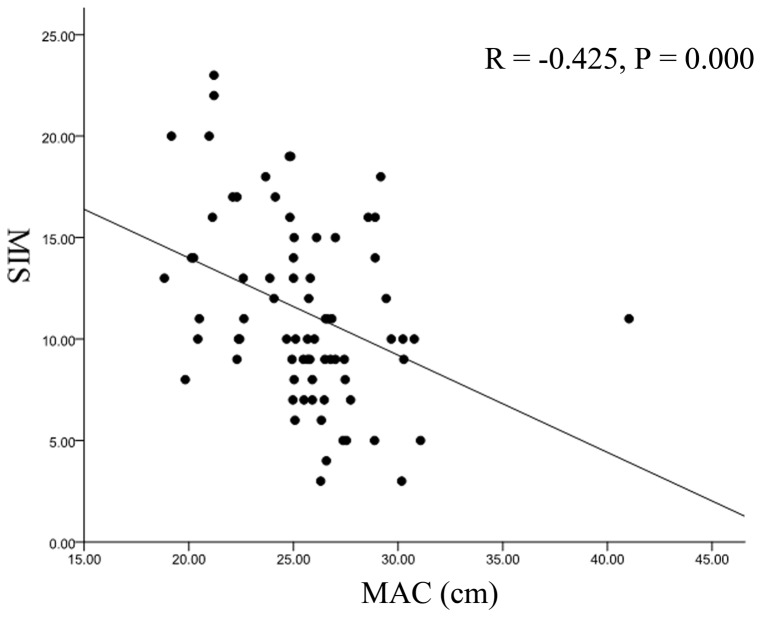
Scatter plots, regression line reflecting the correlation between mid arm circumference (MAC) and malnutrition-inflammation score (MIS).